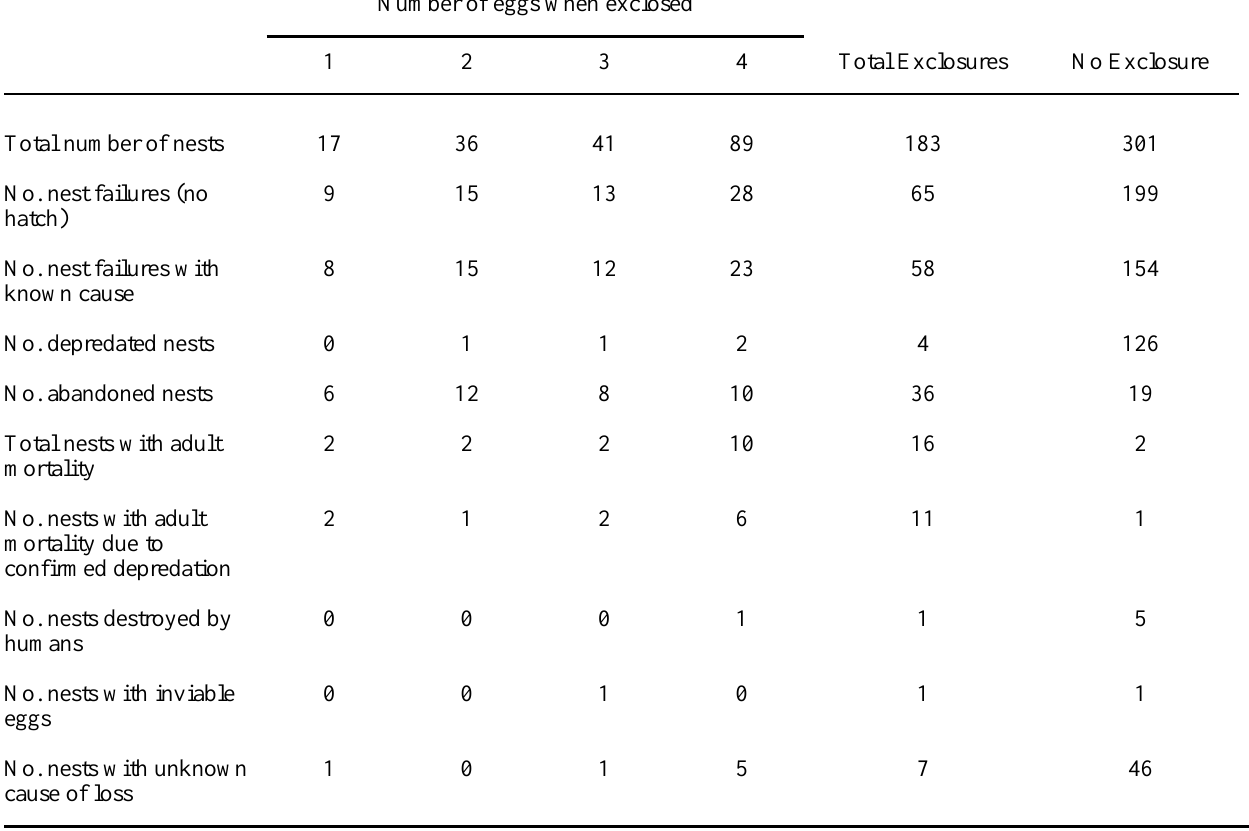
Number of eggs when